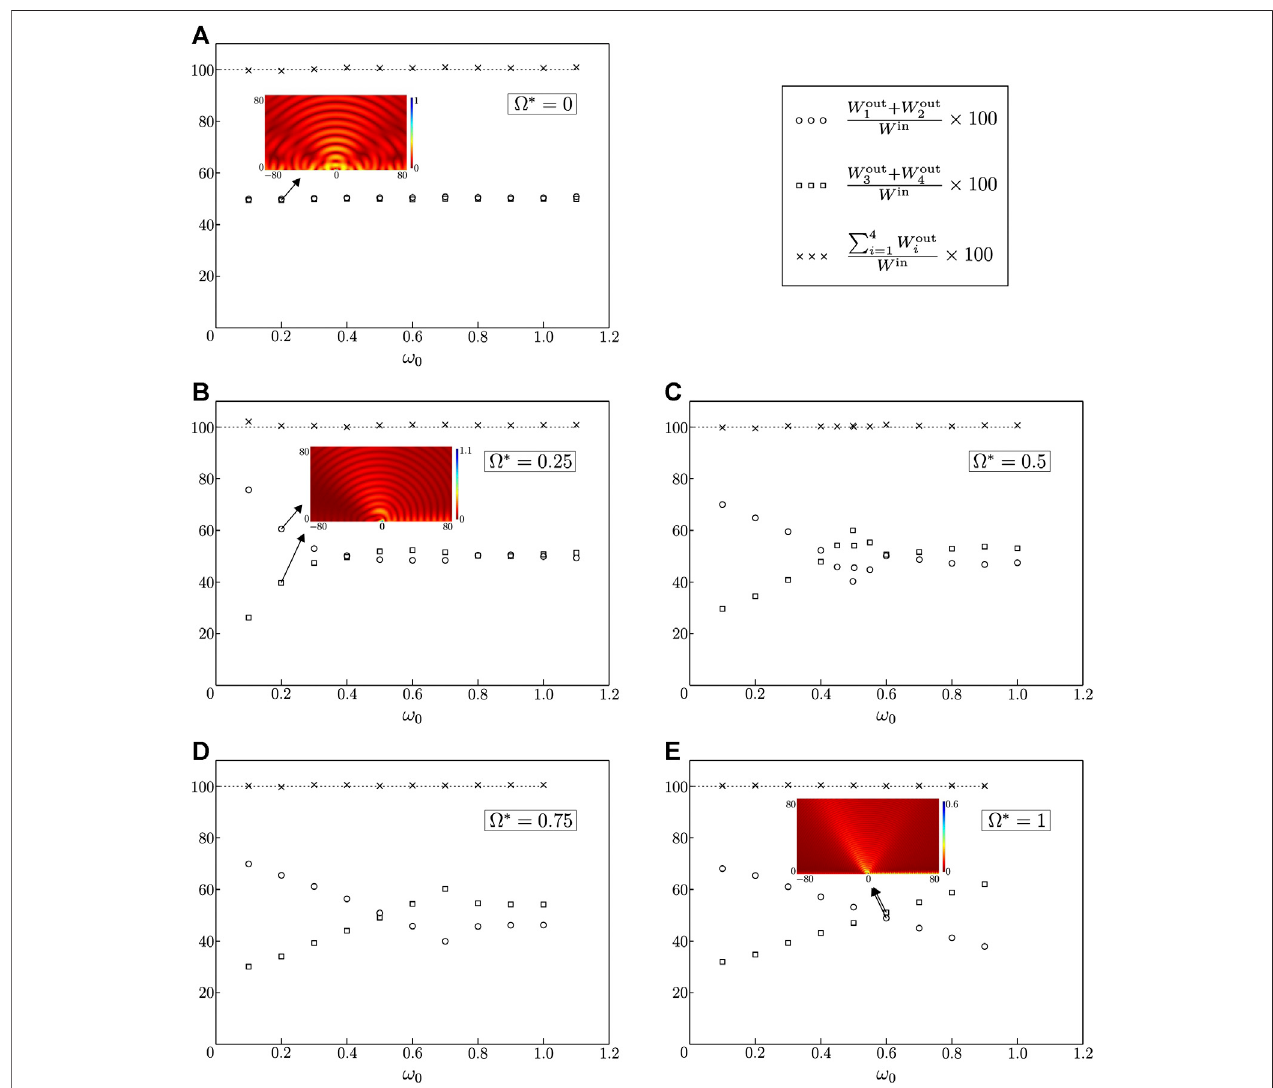
FIGURE 8 | Percentages of energy fl ows propagating to the right ( W out 1 + W out 2 ) and to the left ( W out 3 + W out 4 ) of the point force with respect to the energy fl ow produced by the external load ( W in ), calculated for several values of effective gyricity Ω * and frequency ω 0 . The results in this fi gure correspond to a point force acting in the horizontal direction. The insets illustrate the wave fi elds at speci fi c frequencies ω 0 and gyricities Ω * .